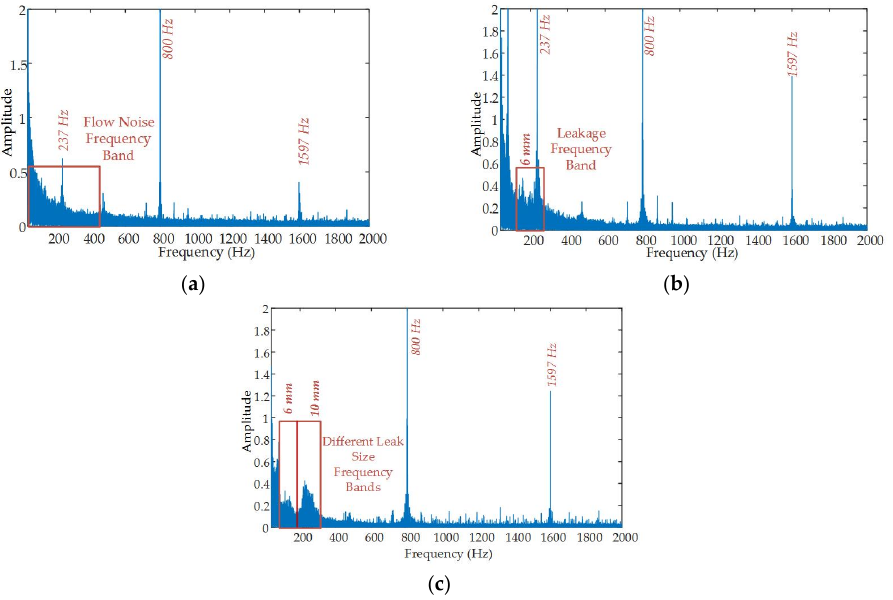
Figure 6. Fast Fourier Transform (FFT) of measured data comprised of background noise and pipeline environment with ( a ) no leakage ( b ) 6 mm leakage size and ( c ) 6 mm and 10 mm leakage size.